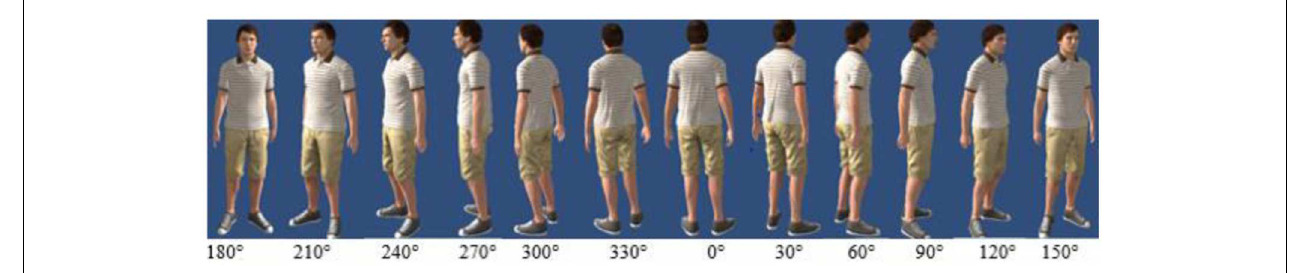
FIGURE 5 | Body orientations tested in Experiment 2.